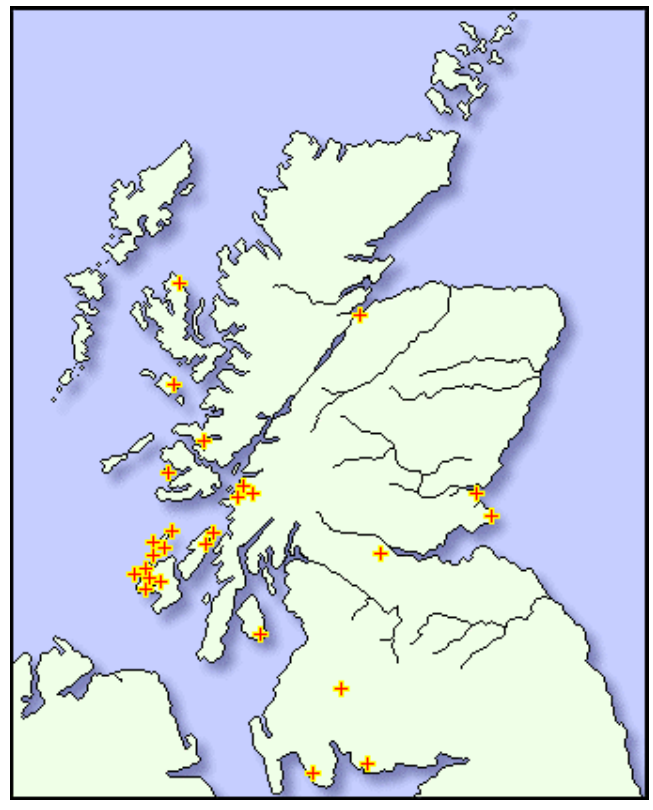
Figure 10 : Interactive map and database of C14-dated mesolithic settlement sites in Scotland (after Ashmore et al